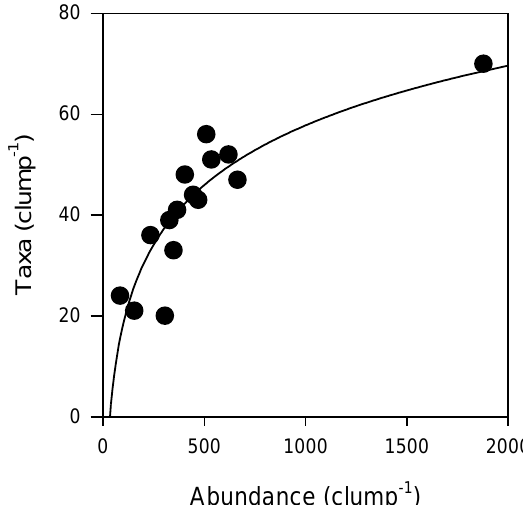
Figure 3. Epifaunal abundance and number of epifaunal taxa per Sabella clump (logarithmic curve fit, R 2 = 0.76, n = 15, see Table S2 for further detail).